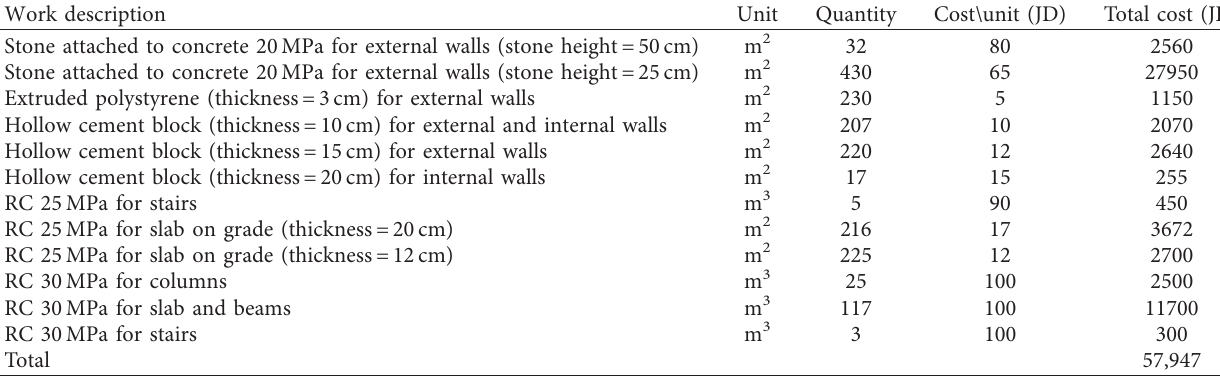
Table 2: Cost of construction works above ground level by conventional construction.